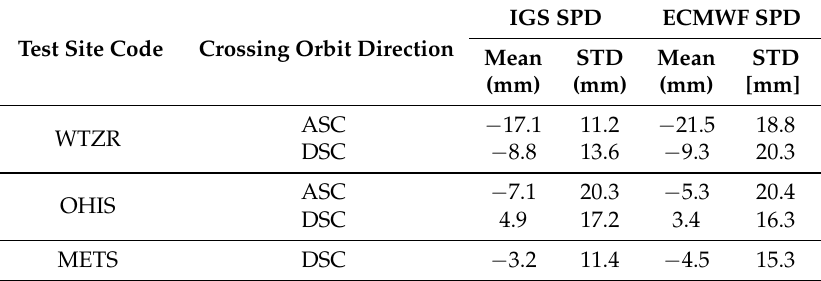
Table 4. Statistical analysis of absolute range residuals using IGS SPD (mapped ZPD) and integrated Peninsula and Metsähovi (METS) in